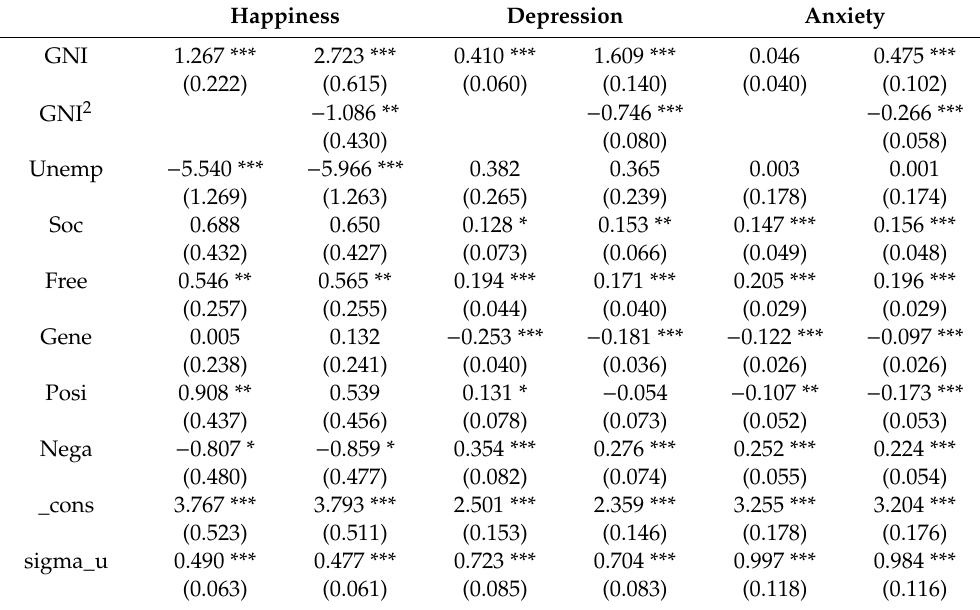
Table 6. The impact of national income on mental health among middle-income countries. Happiness Depression Anxiety